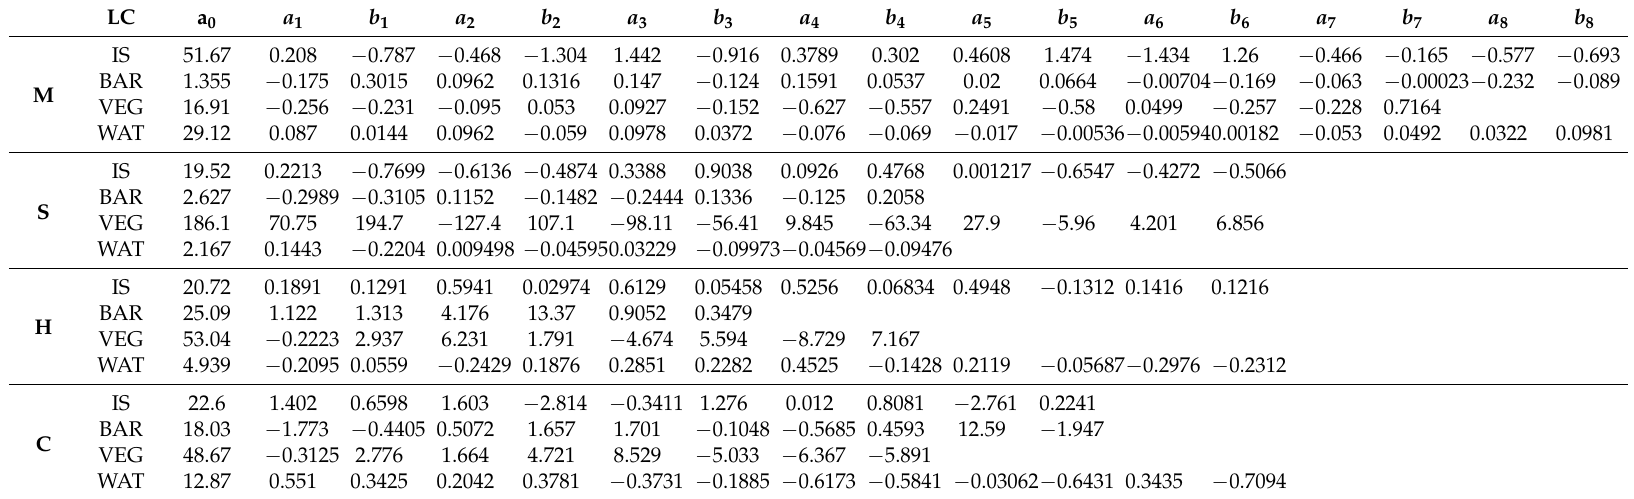
Table 1. Fitting coefficients of the Fourier series for the different land cover (LC) types in four cities; Melbourne is presented as M, Sao Paulo as S, Hamburg as H, and Chicago as C. Impervious surfaces are abbreviated as IS, bare land as BAR, vegetation as VEG, and water as